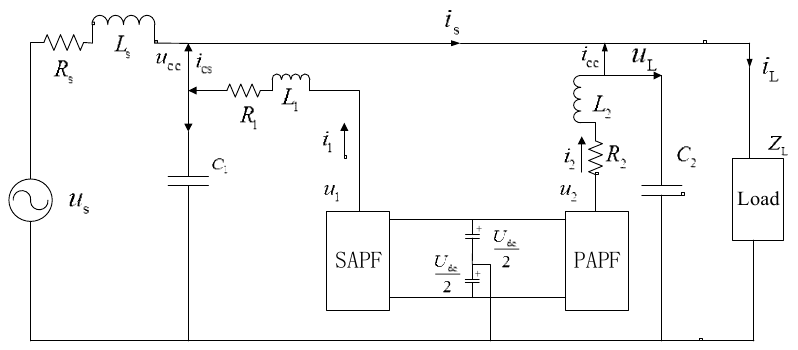
Figure 2. Equivalent circuit based on the d -axis.